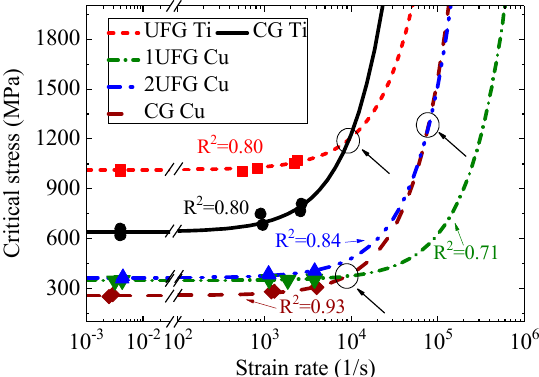
Figure 8. Strain rate dependence of critical yield stress (stress at strain of 0.2%) in titanium and copper under compression. Curves are calculated by Equation (3). R 2 is the coefficients of determination. Table 2. Parameters of titanium and copper: σ comp is the quasi-static compression yield stress YS (at 0.2% strain); τ comp is the incubation time of plastic yield under compression; E comp is the modulus of elasticity under compression. Mean (standard deviation).